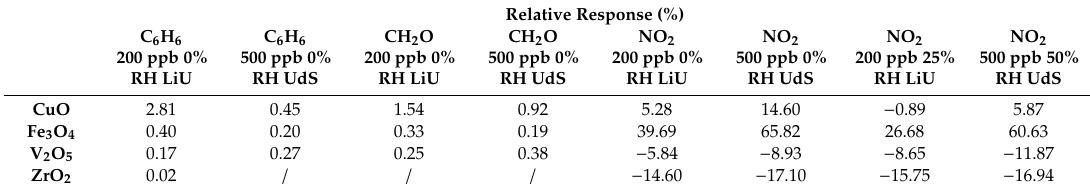
Table 2. Summary of responses of all sensors towards C 6 H 6 , CH 2 O, and NO 2 at 150 ◦ C under dry and humid